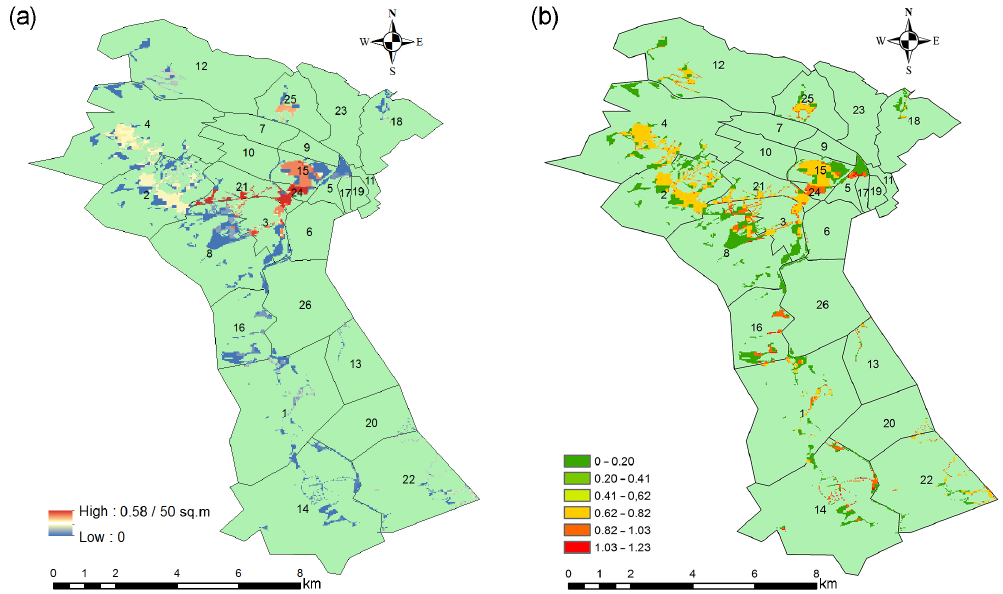
Figure 5. Spatial results describing the probability of injury in the baseline overnight flood scenario: mean (a) and coefficient of variation (b) of distribution. Note: numbering of districts refer to ID column in Table 4. Table 4. Affected human individuals per district or municipality-overnight